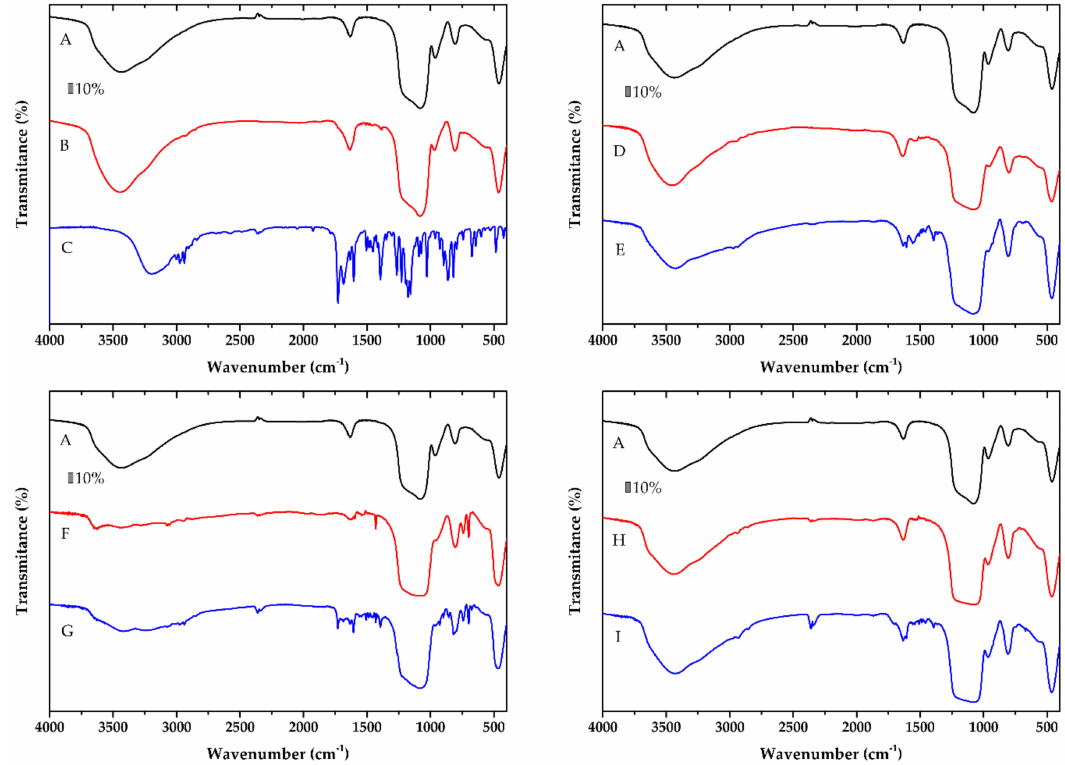
Figure 5. FT-IR spectra of SBA-15 ( A ), SBA-15-NAP ( B ), NAP ( C ) N-SBA-15 ( D ), N-SBA-15-NAP ( E ), F-SBA-15 ( F ), F-SBA-15-NAP ( G ), C-SBA-15 ( H ) and C-SBA-15-NAP ( I